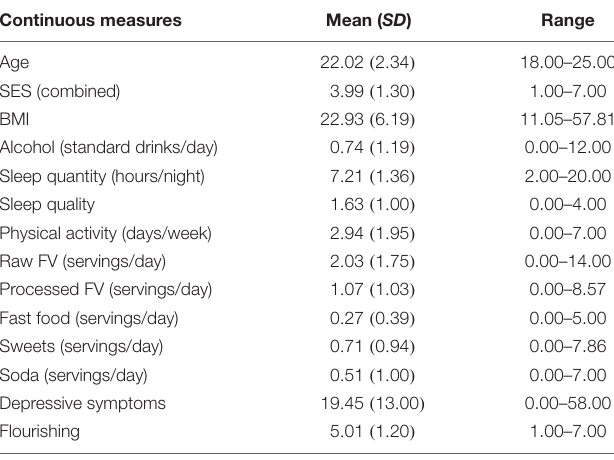
TABLE 2 | Descriptive statistics for continuous participant characteristics, health behaviors, and psychological outcomes. Continuous